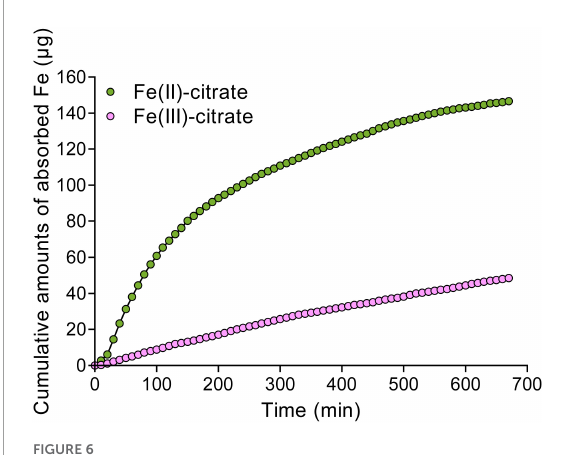
FIGURE6 The Fe adsorption kinetics of cell wall for Fe(II)–citrate and Fe(III)–citrate. Ten milligrams of cell wall powder was placed in a 2-ml column. The composition of adsorption solution consisted of 0.1 M sodium acetate (pH 5.0) solution with 50 µ M Fe(II)–citrate or Fe(III)–citrate. Then, the residual iron concentration in the collected solution was measured with 2,2-bipyridyl as described in “Materials and methods” section.